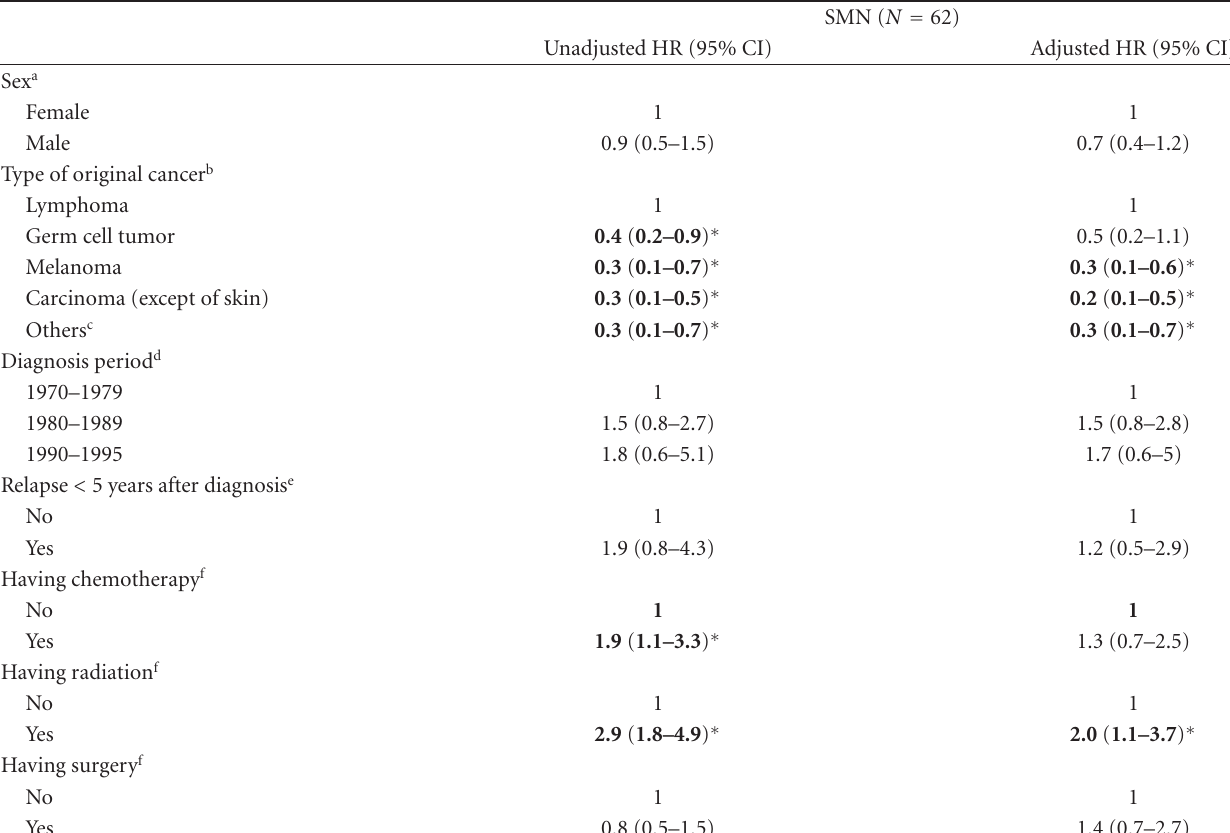
Table 5: Hazard ratio of